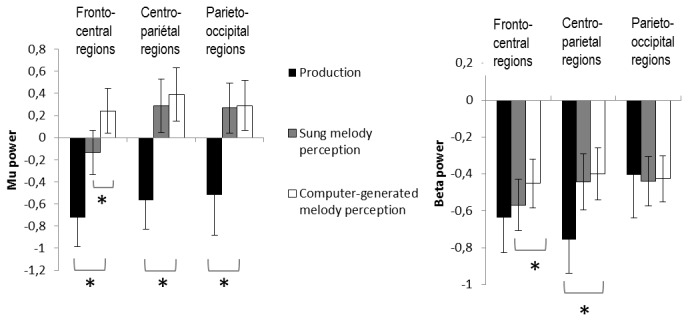
Beta and mu suppression in the experimental conditions.Bars represent the mean power in the beta (14-21Hz) and mu frequency bands (7.5-12Hz) during the three conditions (Production, Vocal melody perception, Non-vocal melody perception), over the power in the baseline, for the fronto-central, centro-parietal and parieto-occipital regions. Data from the left and right hemispheres are averaged. Error bars indicate the standard error of the mean and asterisks correspond to the significant differences (p<.05) between conditions (Bottom: Production versus Perception, Top: Vocal melodies versus Non-vocal melodies), according to Tukey’s HSD post-hoc tests. Note that differences between vocal and non-vocal in the beta band were only significant over left fronto-central electrodes.